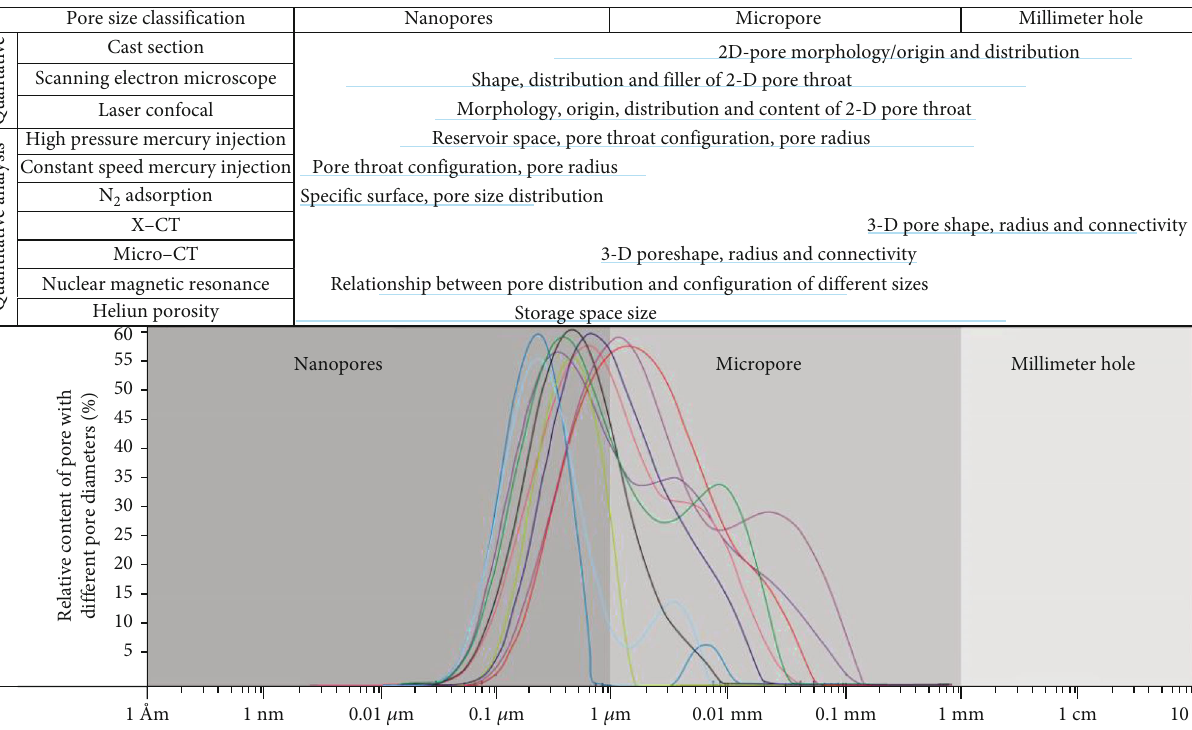
Figure 3: The tight oil reservoir pore radius characteristic and methods